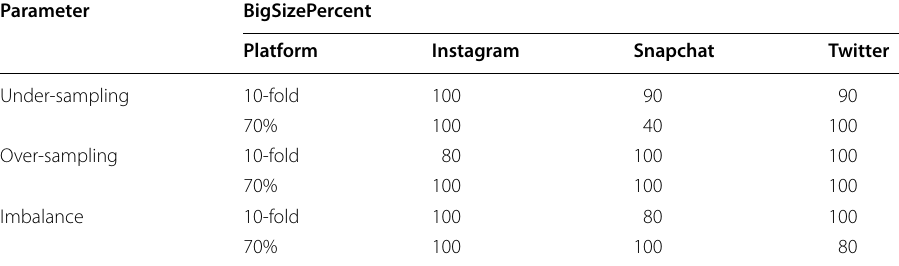
Table 7 summarizes the optimal parameters for both 10-fold cross-validation and 70% split.